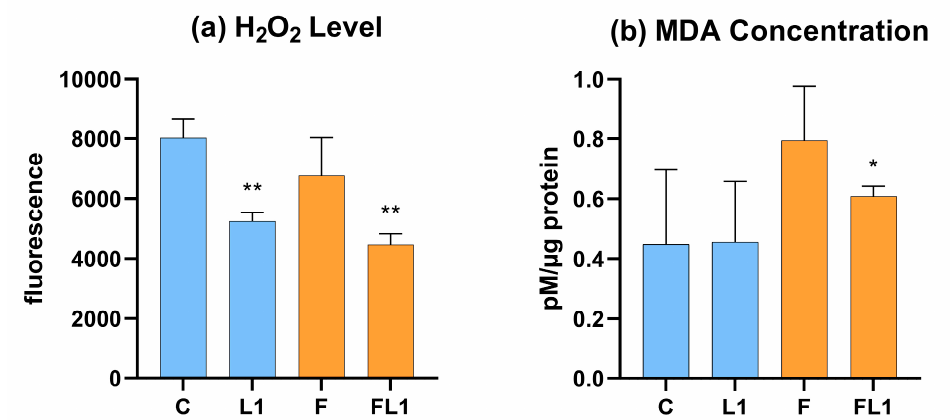
Figure 5. H 2 O 2 level of the cell culture medium measured by Amplex Red fluorimetric assay ( a ) and MDA concentration of the cell lysate measured by a colorimetric assay ( b ). C = control, L1 = luteolin (4 µg/mL), F = flagellin (250 ng/mL), FL1 = flagellin (250 ng/mL) and luteolin (4 µg/mL). Mean ( n = 6/group) ± SD, * p < 0.05, ** p < 0.01. Group L1 and F were compared to C, while group FL1 was compared to group